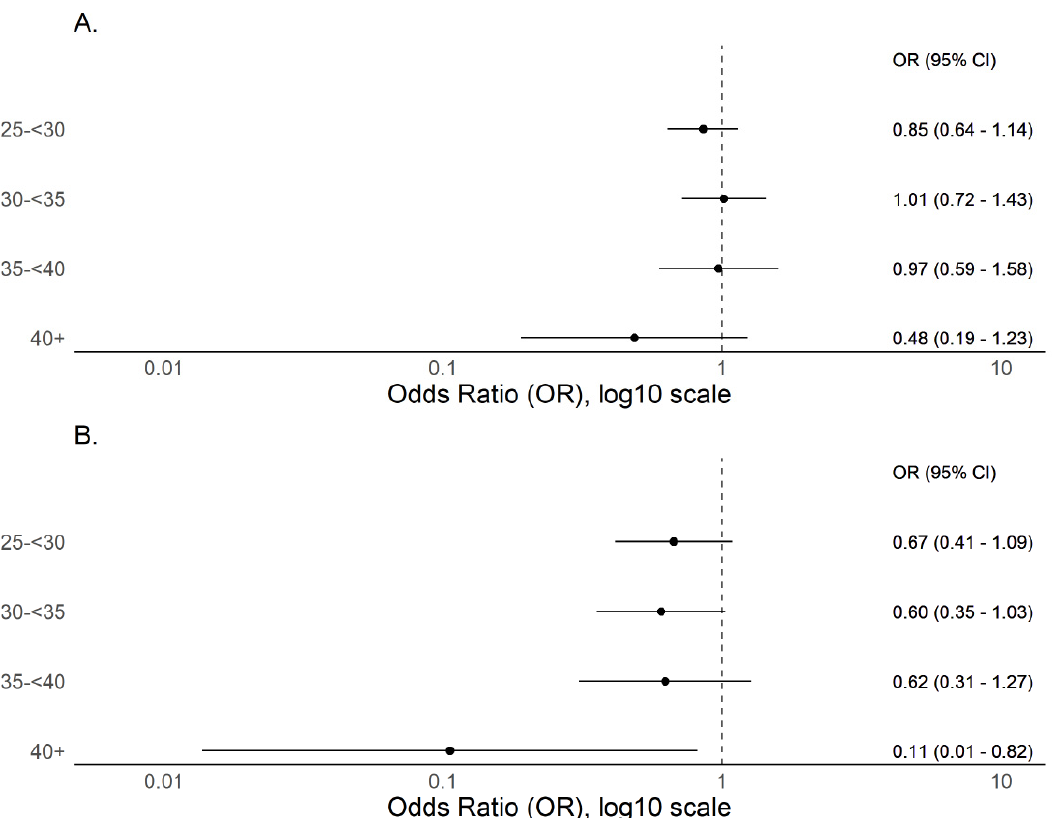
Figure 1. Forest plots of adjusted odds ratio for seropositivity by BMI as a categorical variable with normal BMI (18.5–<25) as reference. ( A ) Includes participants with BMI measures and demonstrates a non-significant trend to declining seroprevalence with BMI ≥ 40 kg/m 2 when compared to normal/healthy weight (BMI 18.5–24 kg/m 2 ) ( n = 4270). ( B ) Includes only participants from a single high seroprevalence (22.5%) location in South Texas, where the high force of infection may more clearly delineate infection risks ( n = 629).